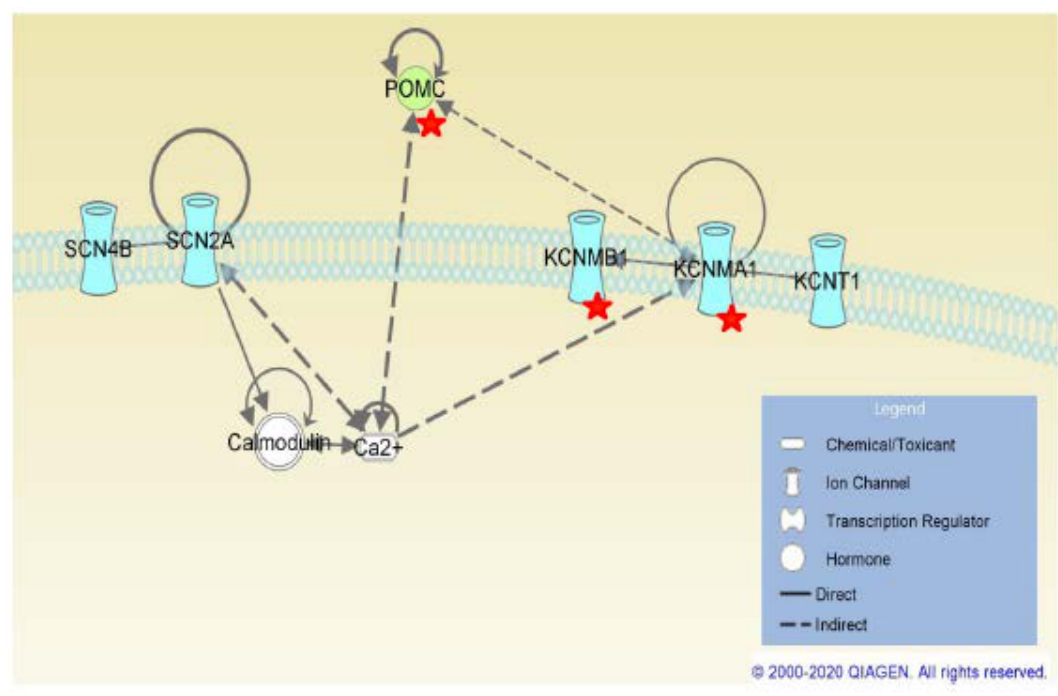
Figure 4. Putative mechanism involving SCN4B (IPA findings). Molecules with a red star are co-expressed with SCN4B . Figure produced using Ingenuity Pathway Analysis (IPA) (QIAGEN Inc., https://www.qiagenbioinformatics.com/products/ingenuity-pathway-analysis).